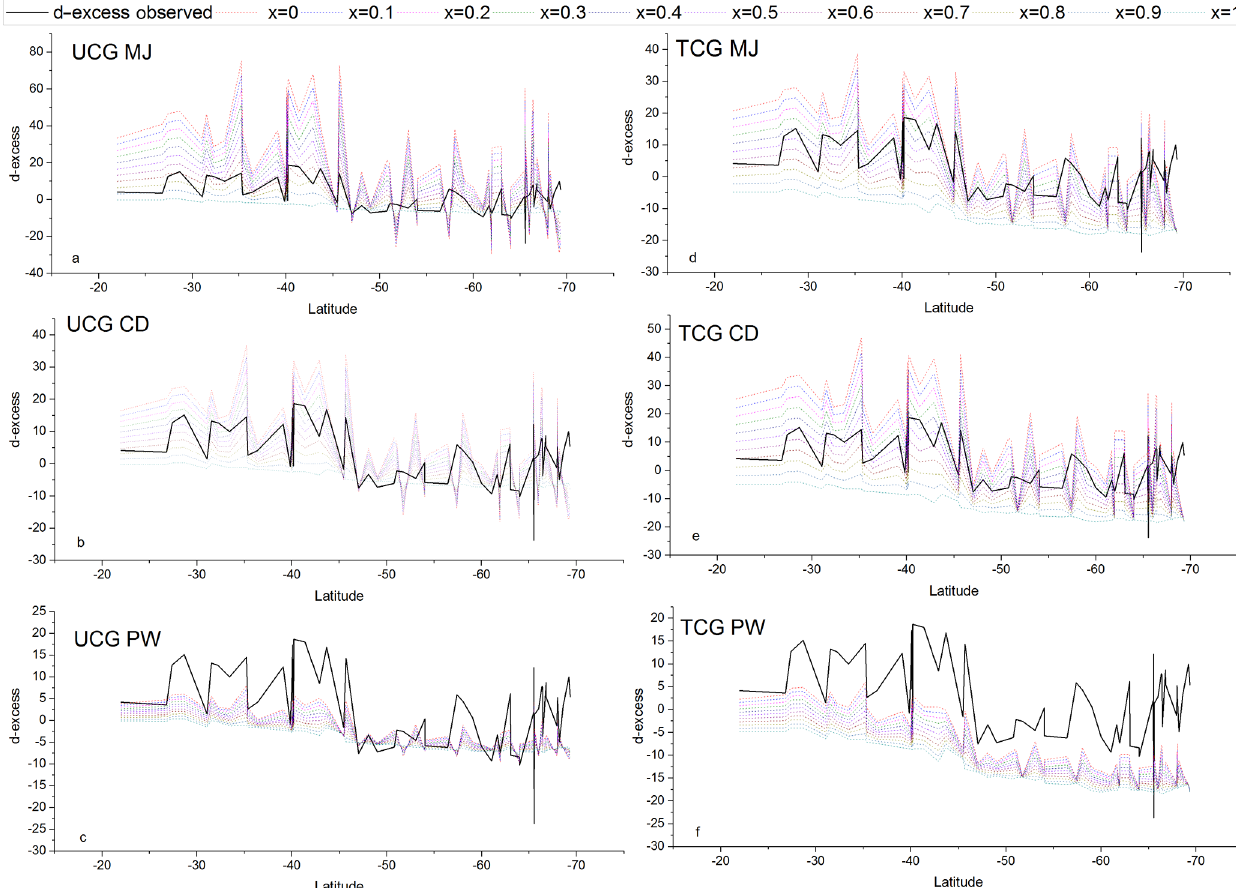
Figure 8. Comparison between the latitudinal distribution of the measured d-excess in water vapor (black lines) and that predicted by the TCG and UCG models, employing the global closure assumption for different molecular diffusivity ratios and turbulence indices, shown as colored